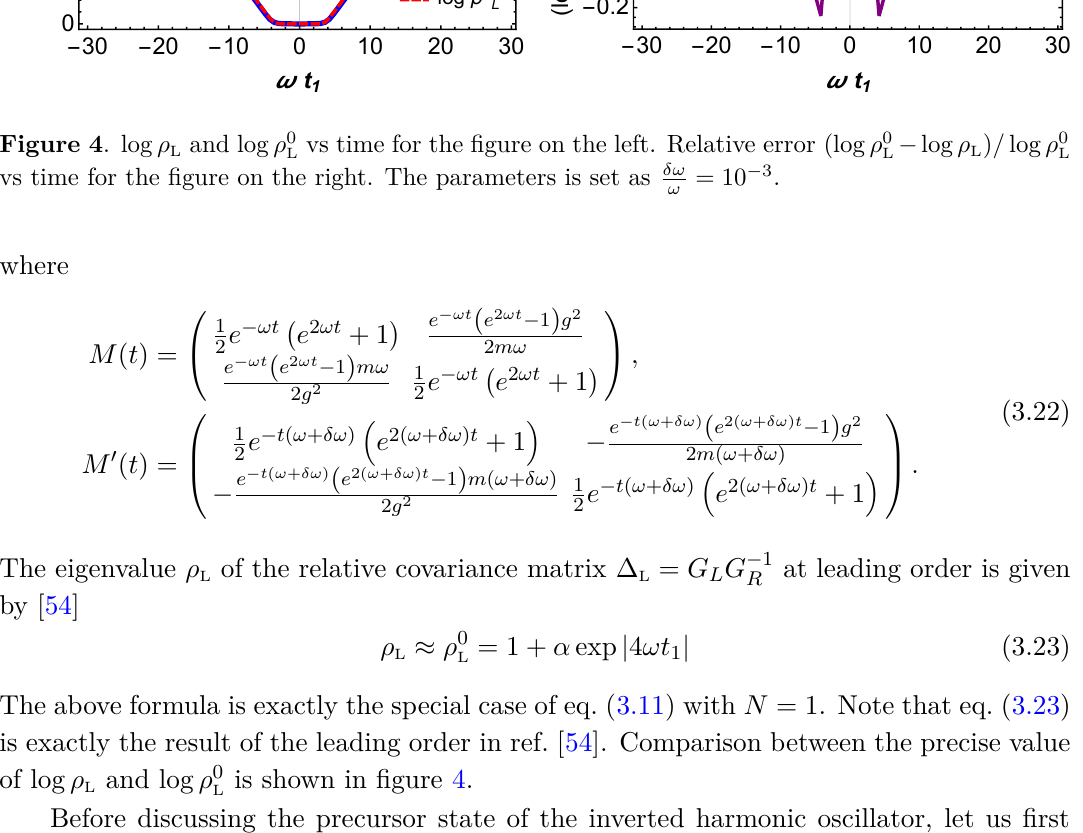
and log ρ 0 vs time for the figure on the left. Relative error (log ρ 0 L L